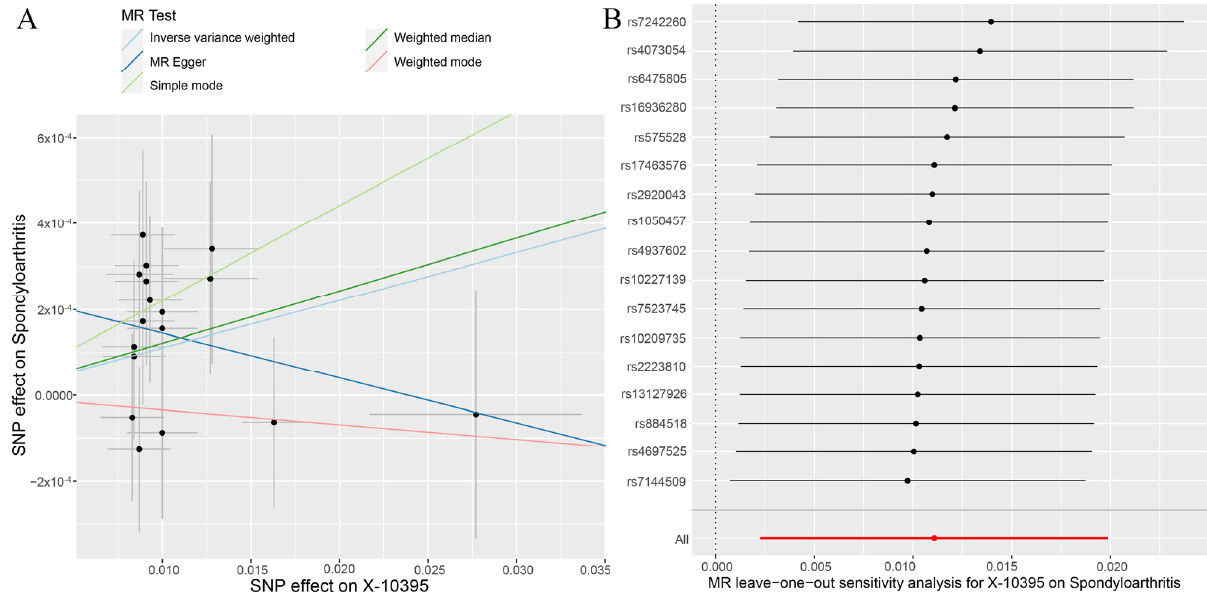
Figure 3. MR analysis results of the X-10395 and spondyloarthritis. ( A ) Scatter plot; ( B ) leave-one-out analysis. Table 2. Sensitivity analysis of the MR analysis results of human blood metabolites and